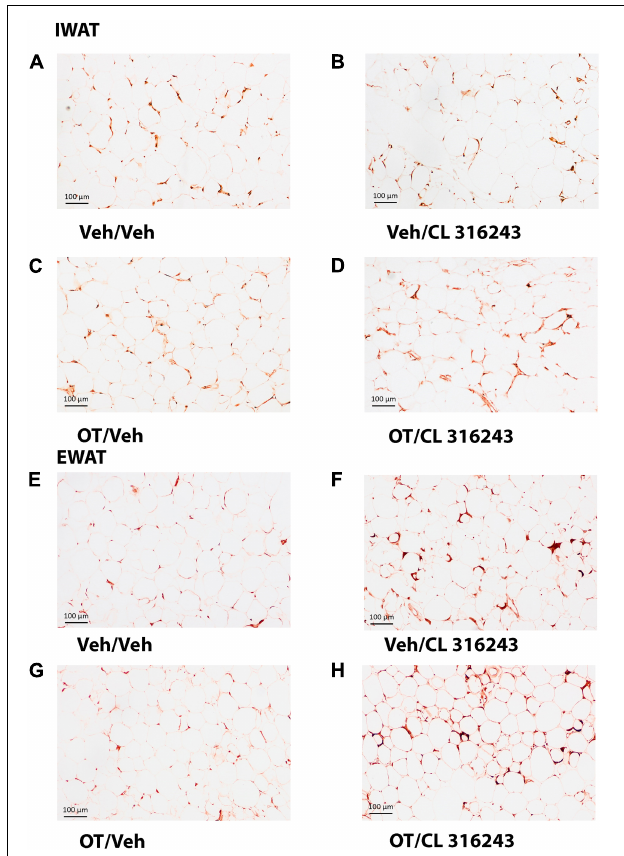
FIGURE 6 | (A–H) Effect of chronic 4V OT infusions (16 nmol/day) and systemic beta-3 receptor agonist (CL 31643) administration (0.5 mg/kg) on UCP-1 content in IWAT and EWAT in male DIO rats. UCP-1 was analyzed using Image Pro Plus software. Images were taken from fixed (4% PFA) paraffin embedded sections (5 µ m) containing IWAT (A–D) or EWAT (E–H) in DIO rats treated with 4V OT (16 nmol/day) or 4V vehicle in combination with IP CL 316243 (0.5 mg/kg) or IP vehicle. A/E, Veh/Veh; B/F, Veh/CL 316243; C/G, OT/Veh; D/H, OT/CL 316243; (A–H) all visualized at 100 × magnification. FIGURE 7 | (A–C) Effect of chronic 4V OT infusions (16 nmol/day) and